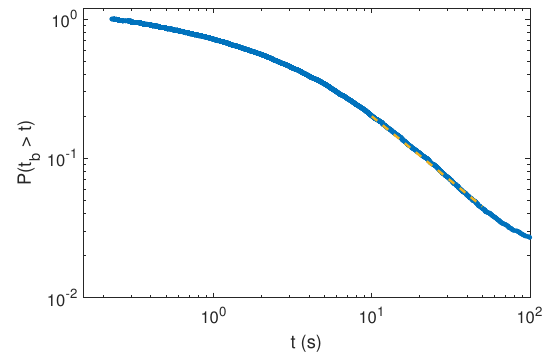
Figure 1. The blue points are the experimental survival function of more than 6000 arches (they look like a continuous trait). They were obtained for a two dimensional silo with a vibrated base; the exit orifice is 2.3 mm wide (beads have a diameter of 1 mm). The sinusoidal vibration has a frequency of f = 90 Hz and an acceleration amplitude of 0.025 g . The dashed line is a linear fit between t = 10 s and t = 50 s , giving α = − 1 .